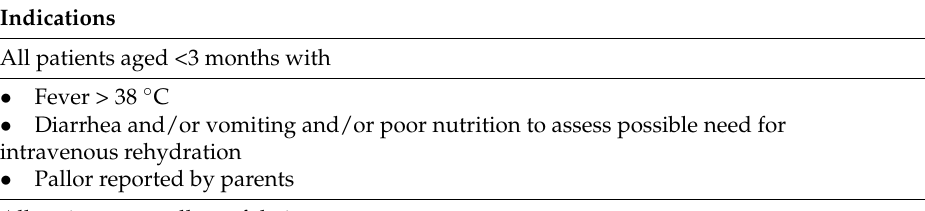
Table 1. Indicators for in-person examination with assessment of vital parameters.